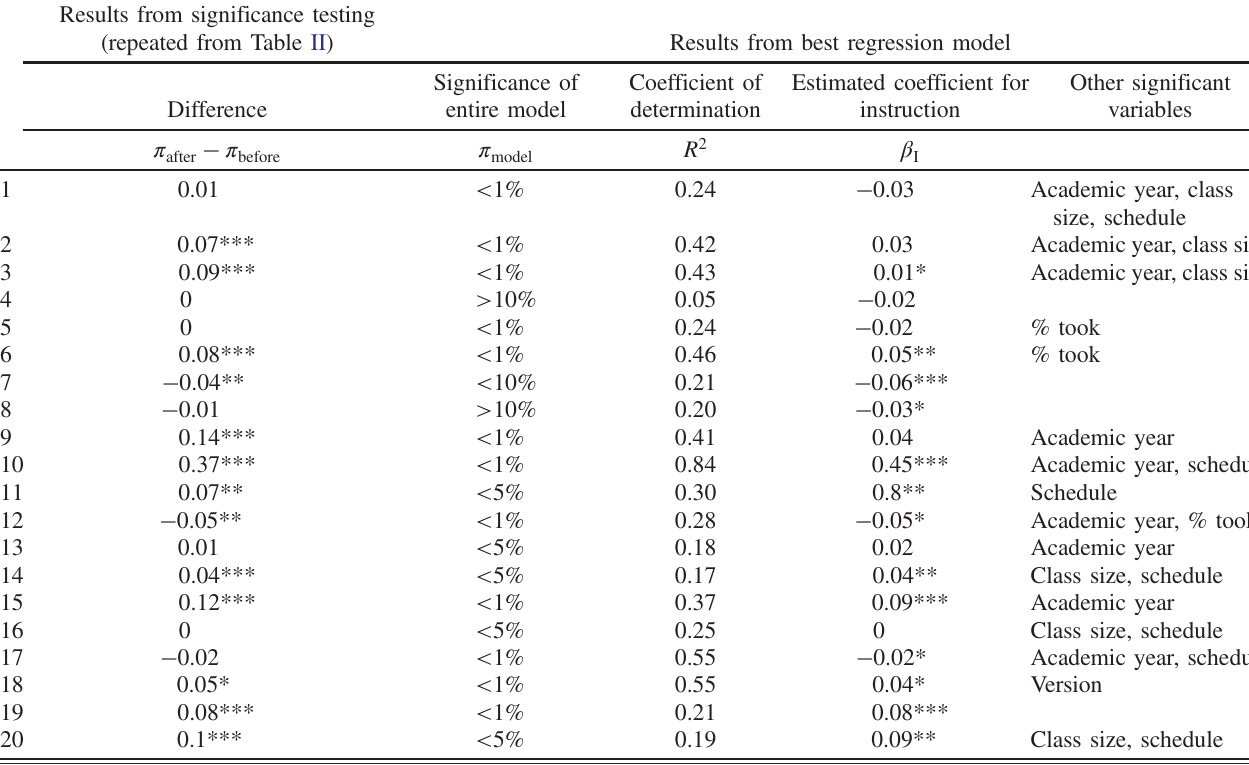
TABLE III. Results from regression analysis. Results from significance